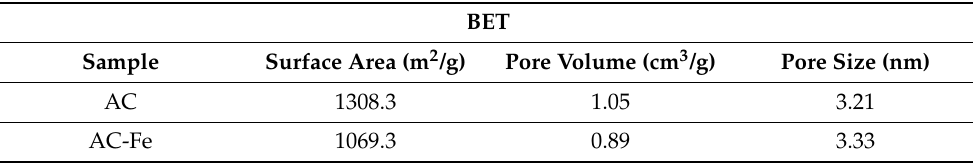
Table 1. Surface area, pore volume, pore size, and pore distribution of AC and AC-Fe.